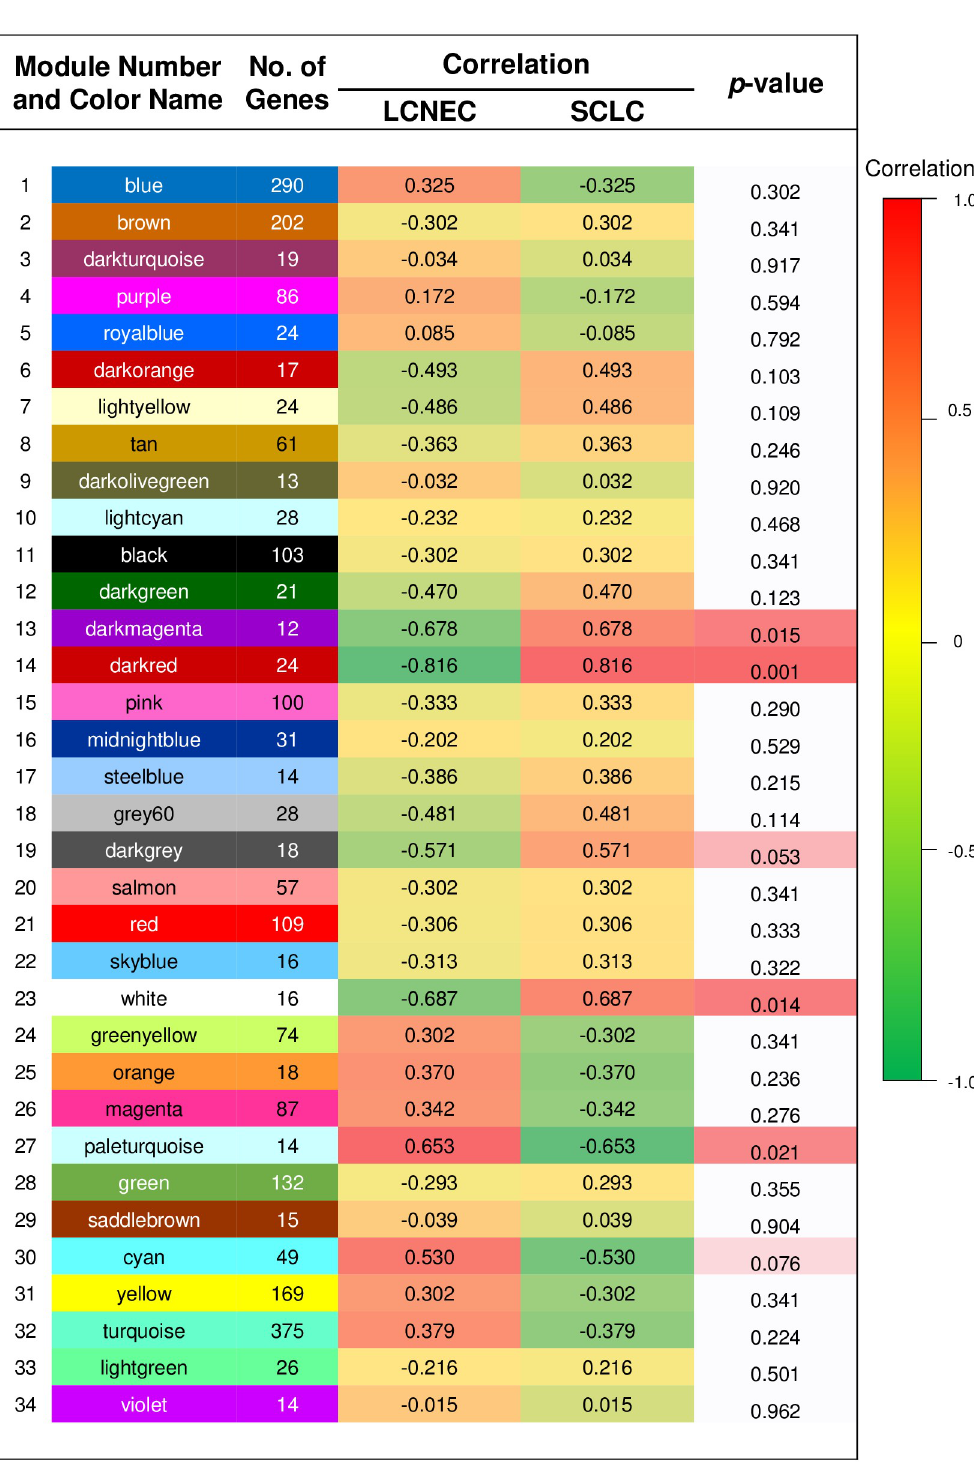
PLOS ONE | https://doi.org/10.1371/journal.pone.0217105 June 5,